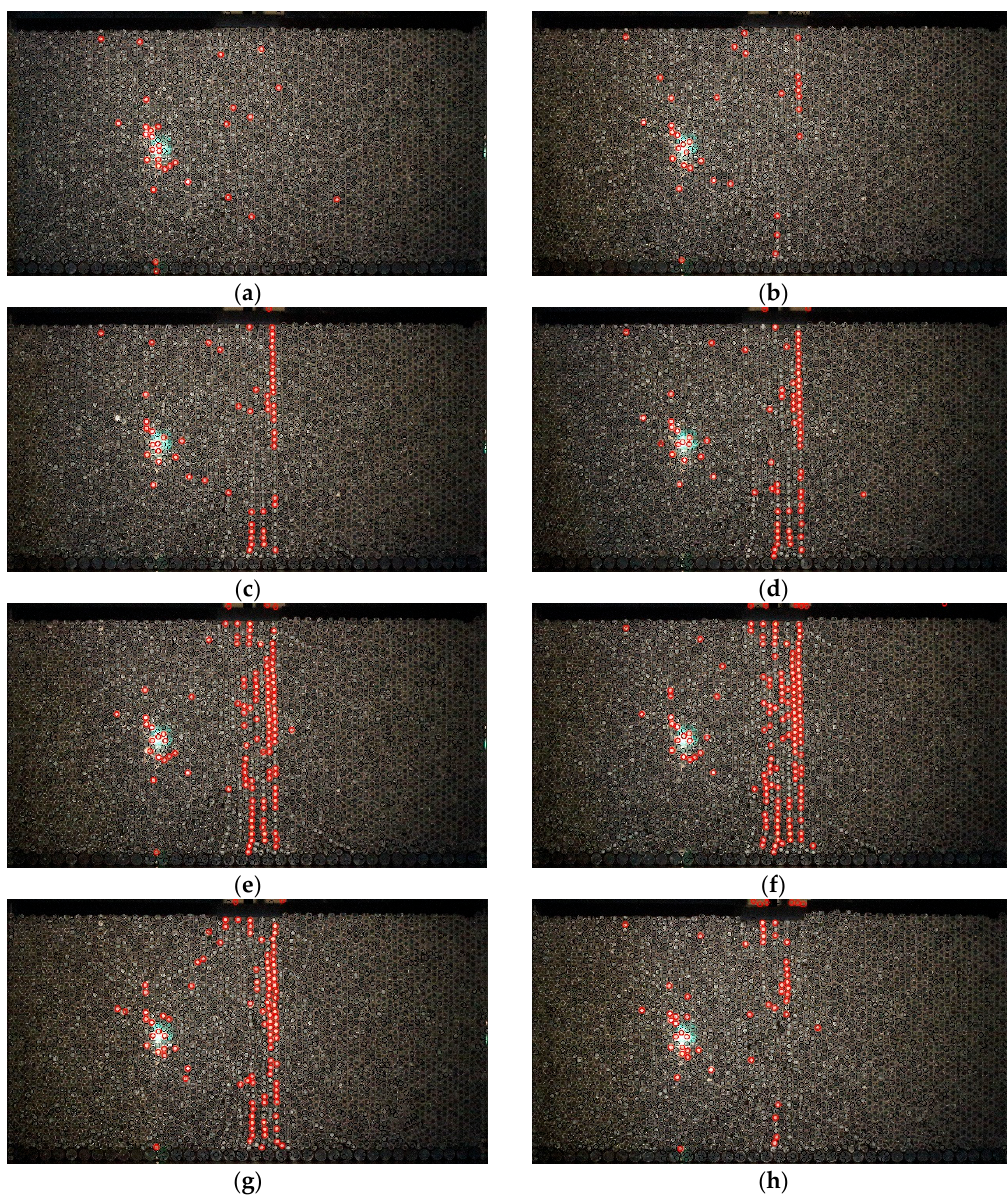
Figure 13. Contact force chains detected by RGB photoelastic digital image analysis during shallow foundation loading with imperfections: (a) before loading; (b) F = 100 N, d = 2.57 mm; (c) F = 200 N, d = 3.22 mm; (d) F = 300 N, d = 4.00 mm; (e) F = 400 N, d = 4.96 mm; (f) F = 450 N, d = 5.29 mm; (g) F = 370 N, d = 5.83 mm; (h) F = 170 N, d = 7.81 mm.